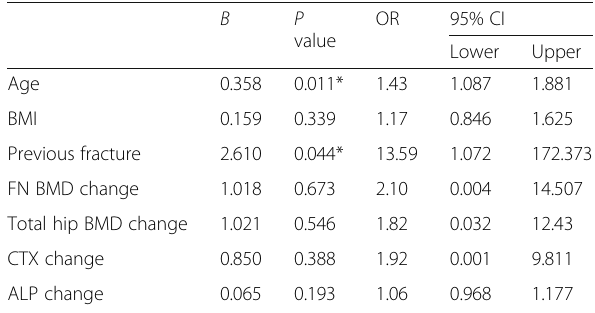
Table 4 Multivariate analysis of vertebral